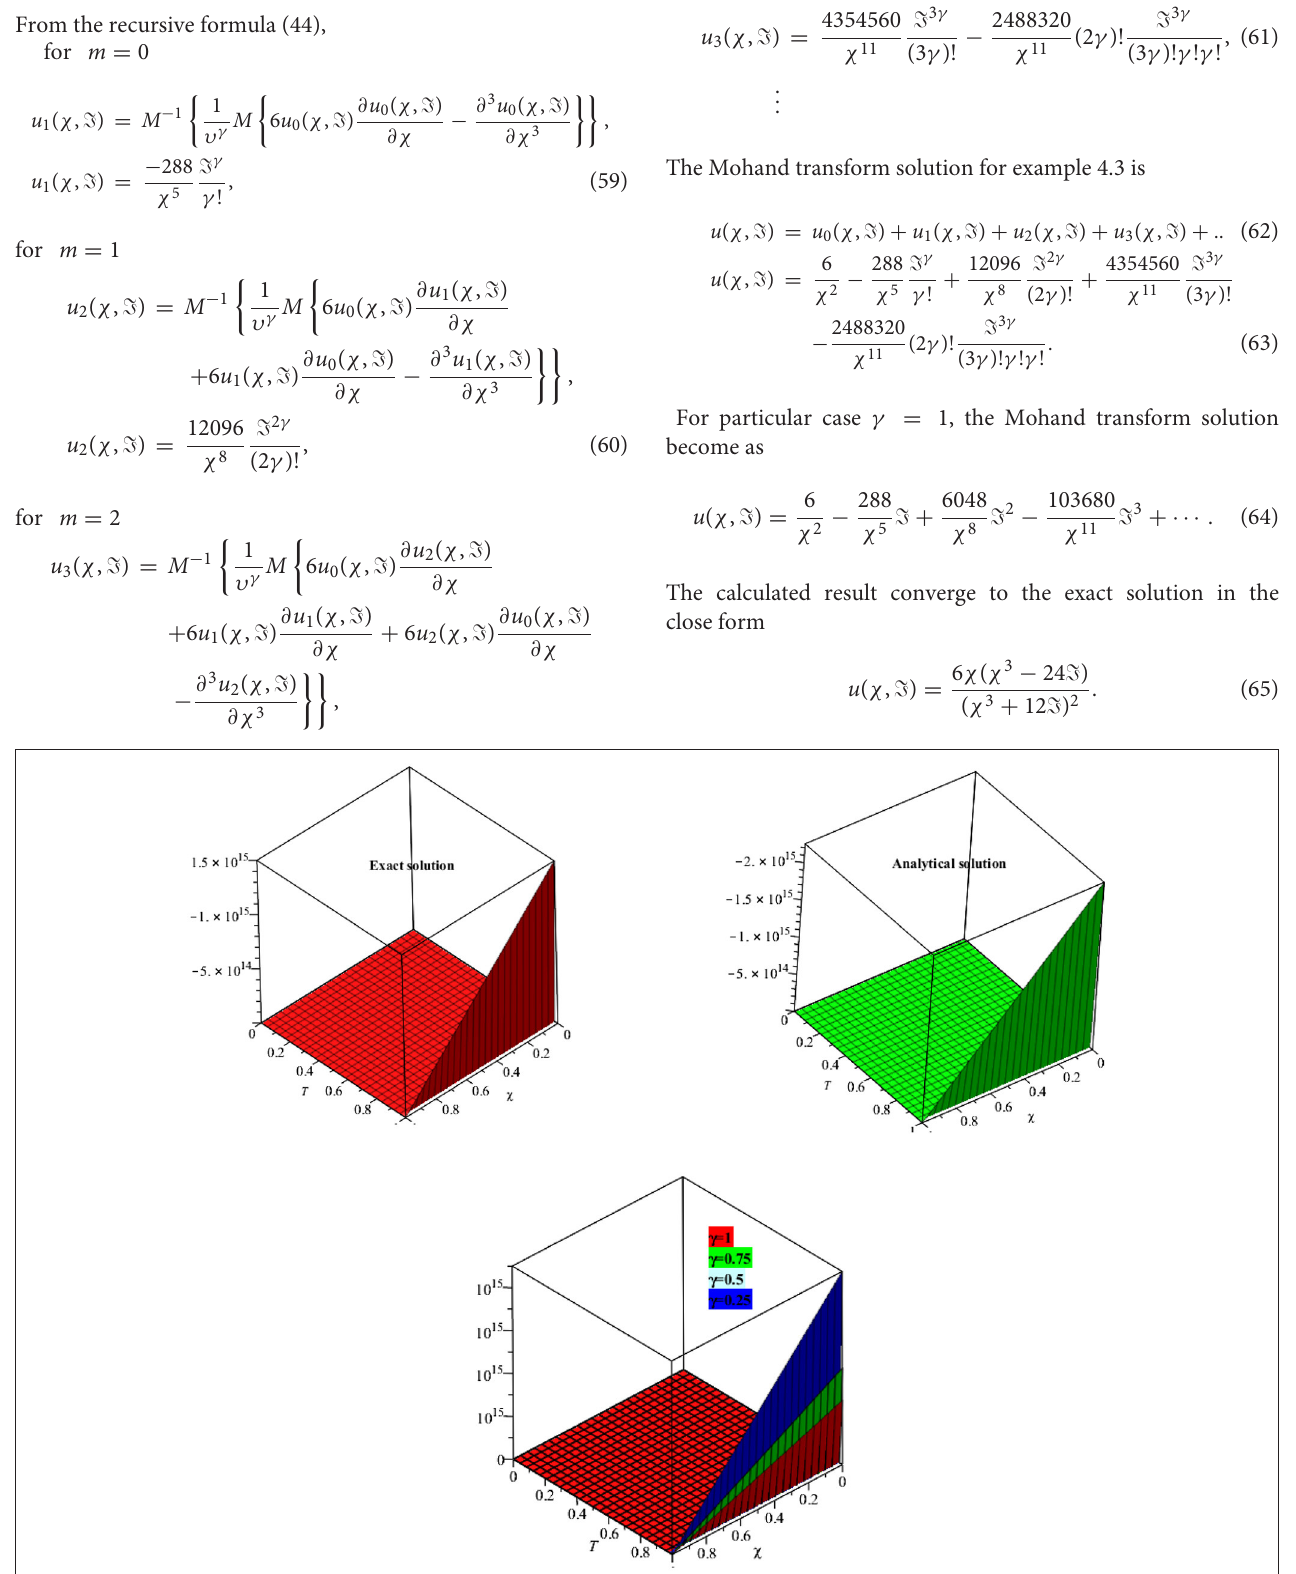
FIGURE 3 | Represents the exact and analytical solution of example